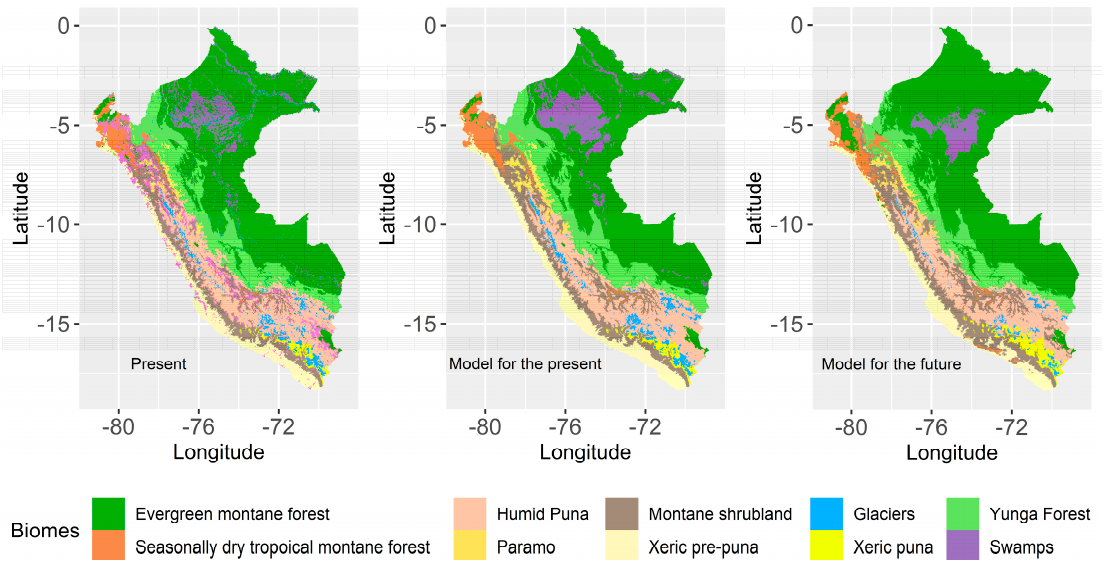
Figure 3. Biome maps of the present based on the MINAM Ecosystem map, representation of the present B with the RF model, and the representation of B projected to 2035–2065 of the ACCES1 model.